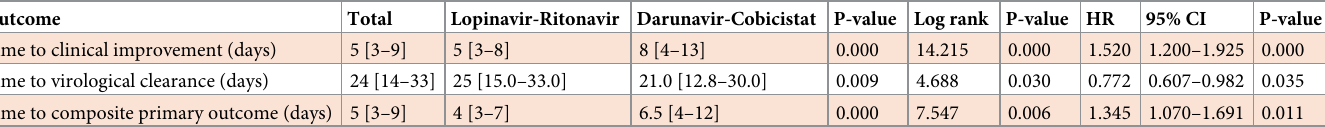
Table 2. Results of the primary study outcomes.